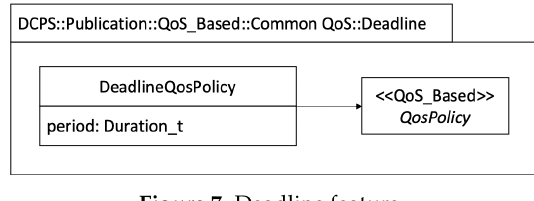
Figure 7. Deadline feature.